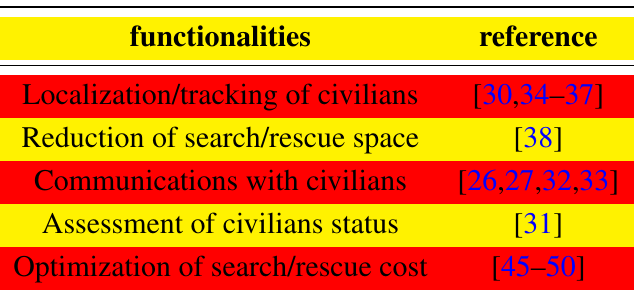
Table 1. A comparison of search and rescue